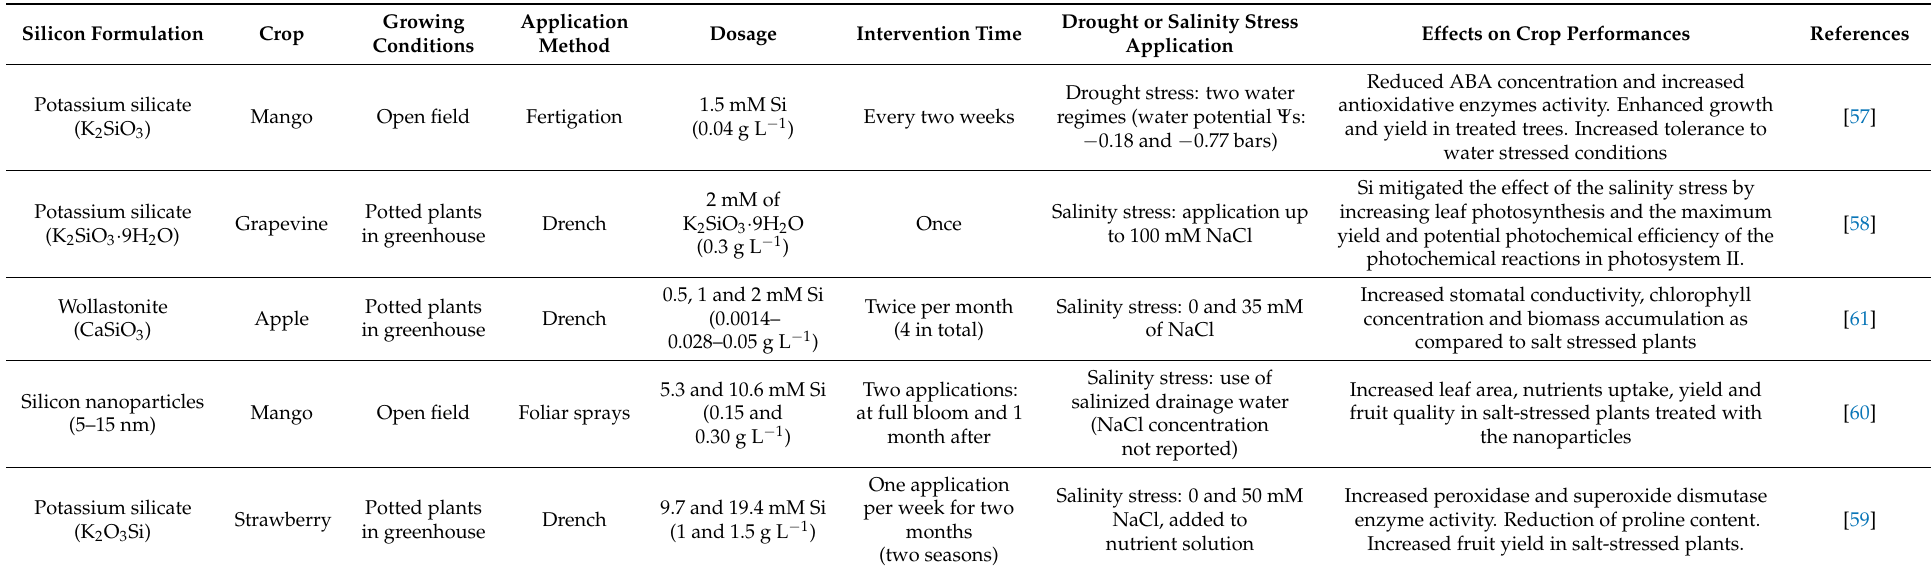
Table 4. Silicon application methods to increase tolerance toward drought and